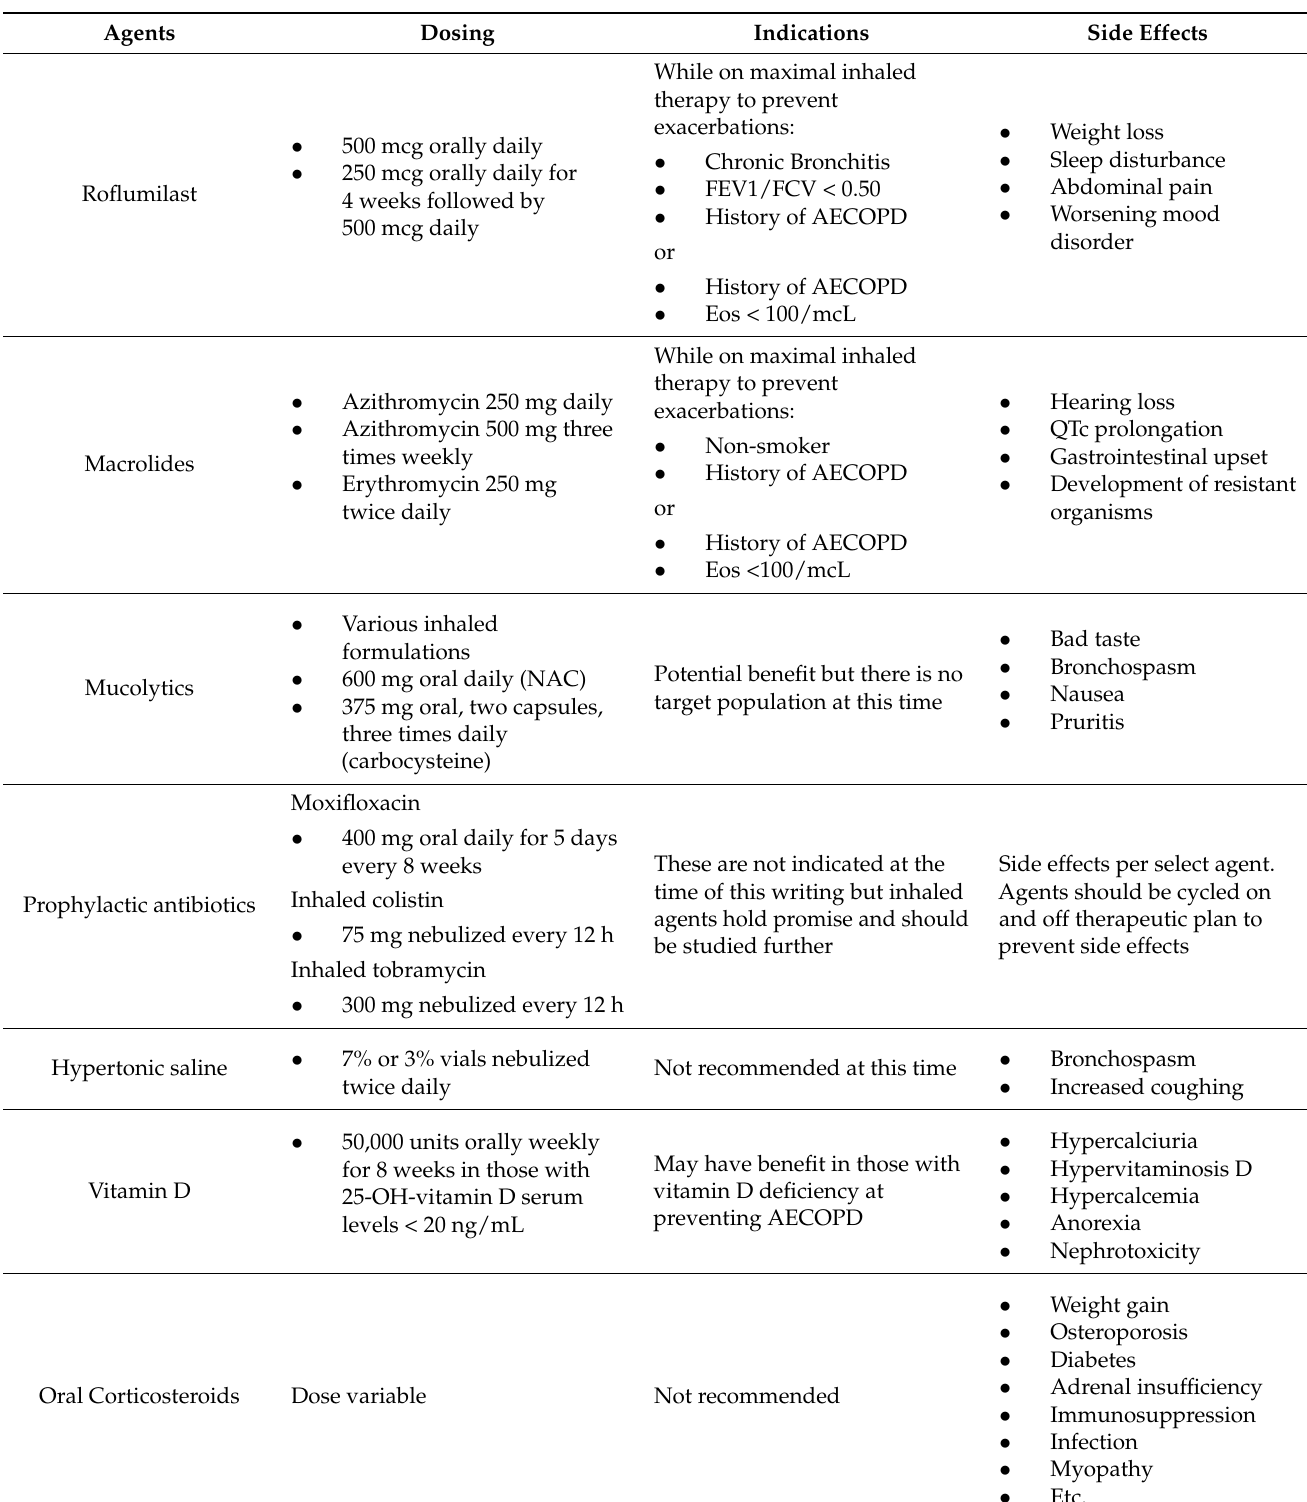
Table 1. Available adjunct therapies in COPD and GOLD 2021 [1]